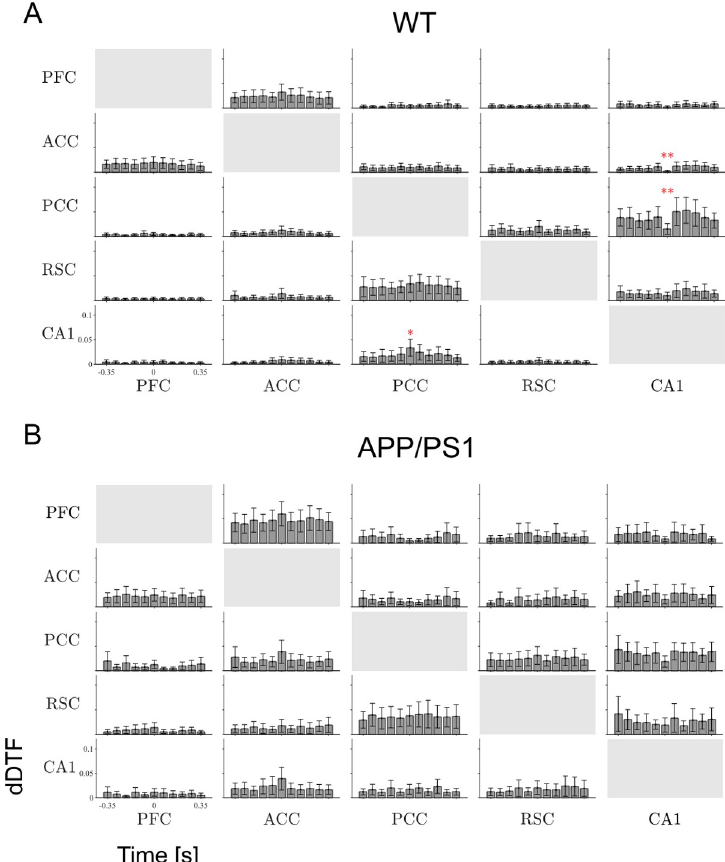
Fig 3. Effective coupling in the slow gamma band. Time course of dDTF value in the slow gamma (20–60 Hz) band, averaged over WT (A) and APP/PS1 (B) mice. Every box shows mean values of interval in consecutive time windows. Significant modification of the coupling value compared to the value of the coupling in the first bin is indicated by stars (Wilcoxon’s test with Bonferroni correction). Other abbreviations as in Fig 2. � p < 0.05, �� p < 0.01, ��� p < 0.001. Time bin size is 70